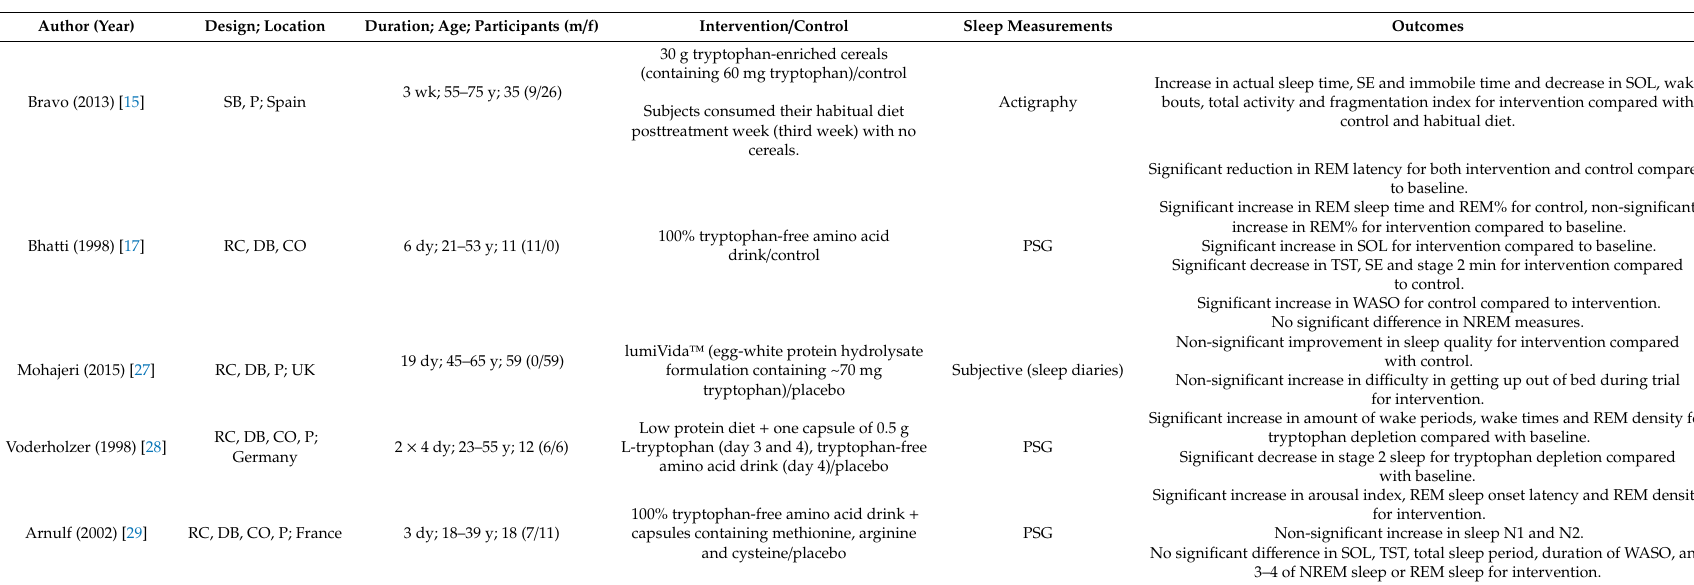
Table 1. The study characteristics and outcomes for the investigations between tryptophan consumption, tryptophan depletion, and